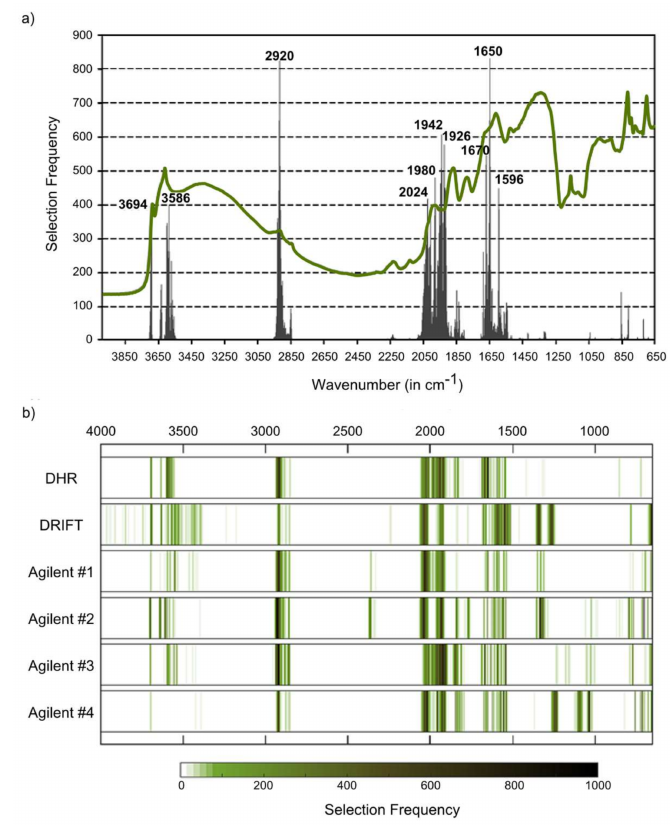
Figure 5. Key wavenumbers for SOC calibrations: ( a ) selection frequencies found for wavenumbers of the DHR measurement series (peaks labelled) overlaid with mean DHR spectrum; ( b ) heat map of SOC selection frequencies for all measured